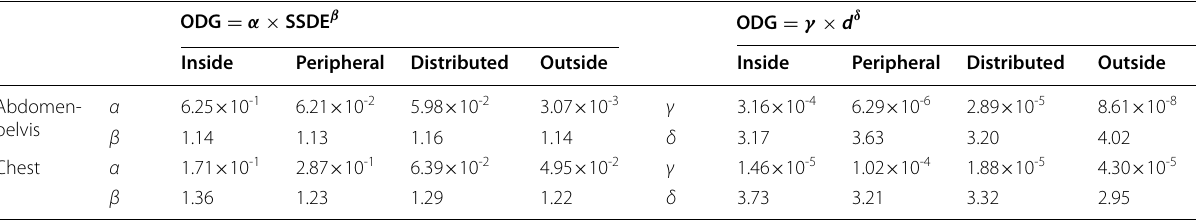
Table 4 Fitting parameters of the power laws ODG = α × SSDE β and ODG = γ × d δ . These fitting parameters were assessed grouping all patients of each cohort. The functional correlation using the adopted power law for SSDE and d for inside, peripheral, distributed and outside organs dose groups are shown. The fitting parameters were calculated using the Levenberg–Maquardt Method